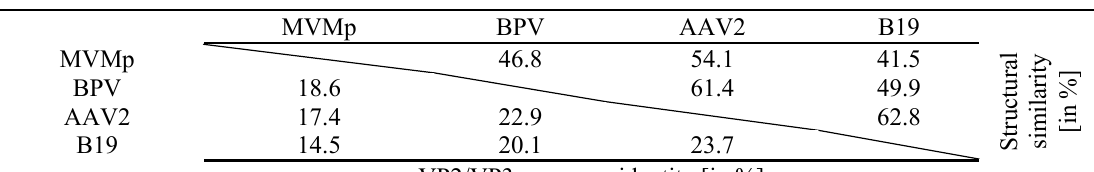
Table 2. Sequence identity and structural similarity among Parvovirinae type members.